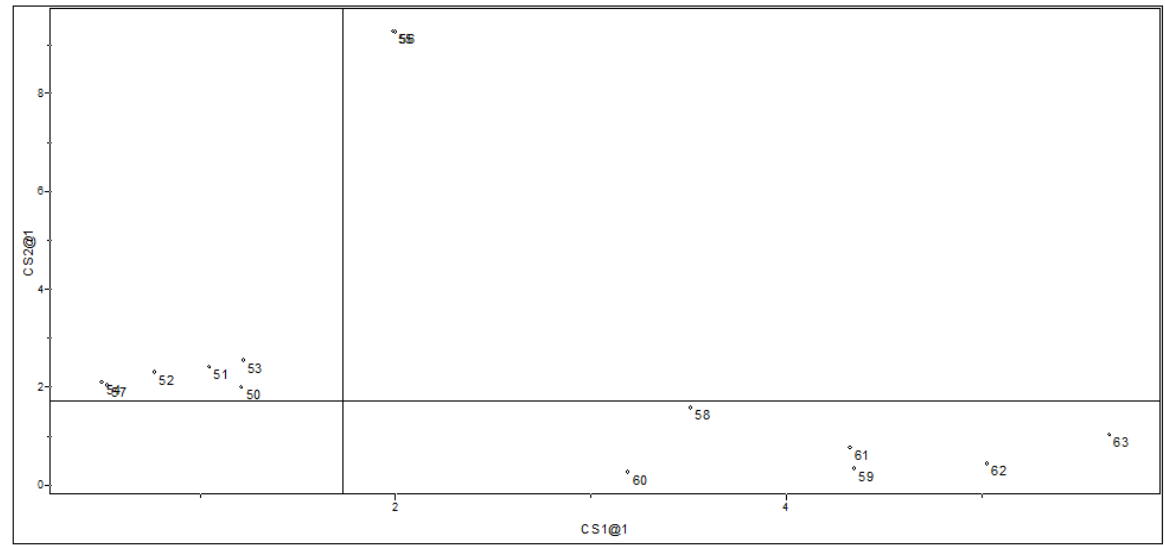
Figure 5. Class distances for SIMCA prediction on the 14 test set